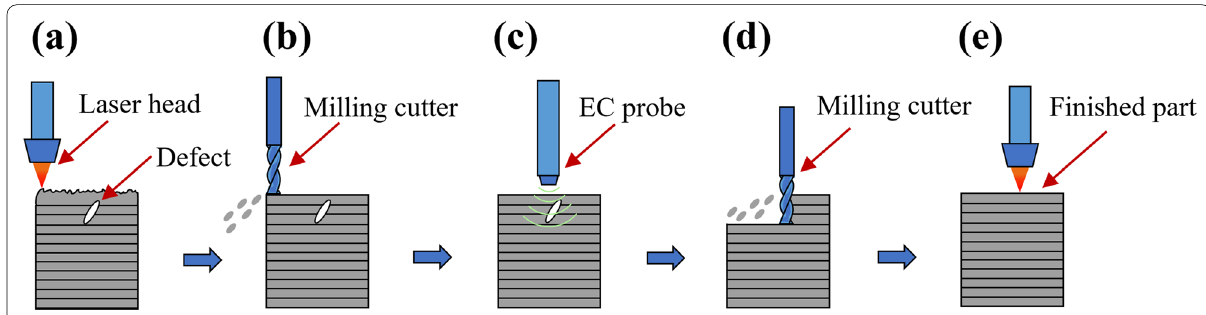
Figure 2 Schematic of the EC-enabled ASHM process [7,